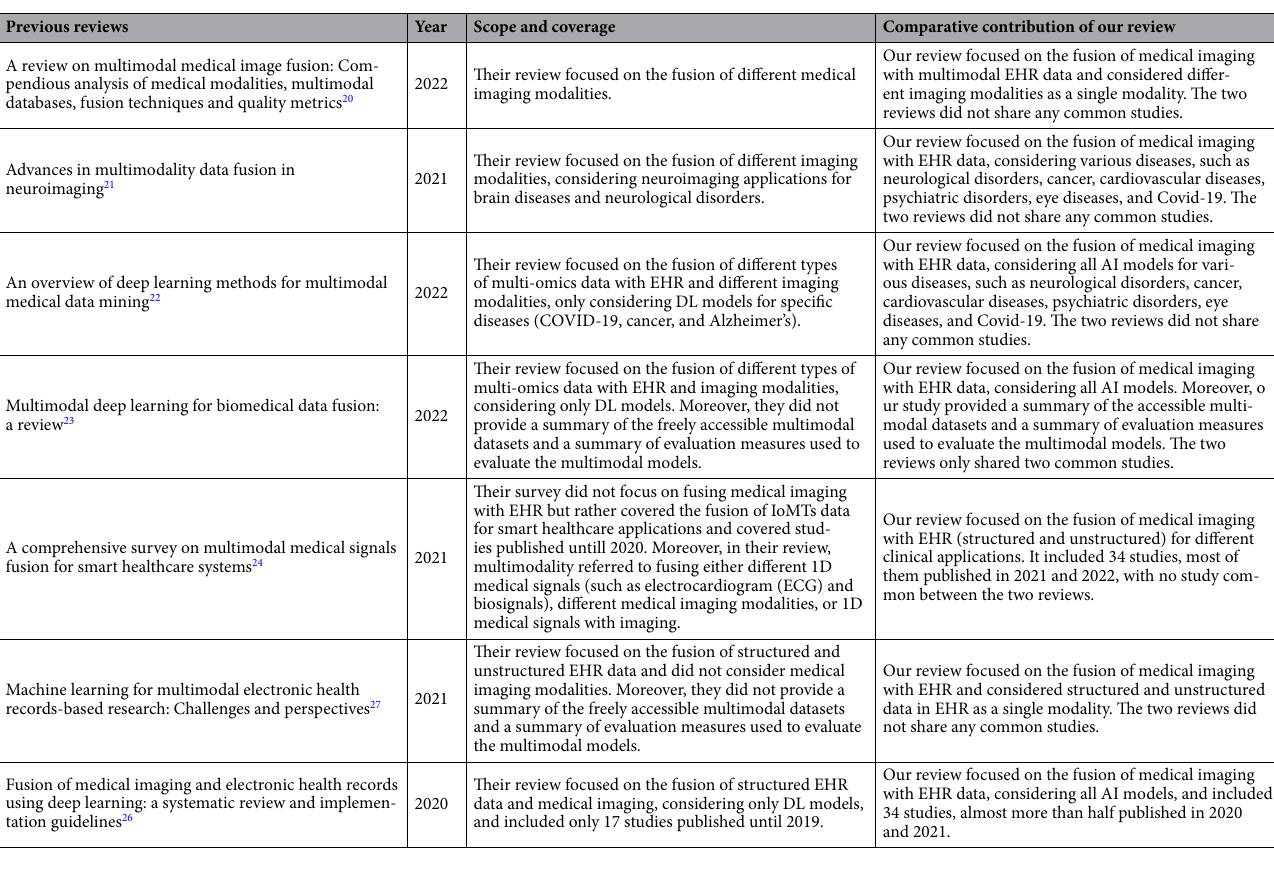
Table 1. Comparison with previous